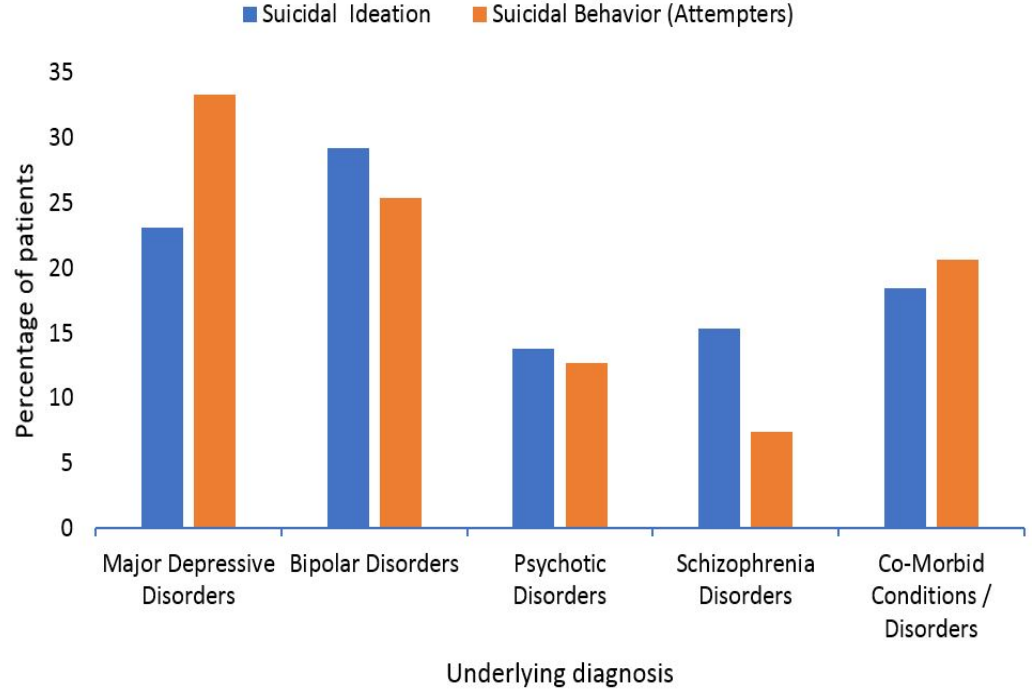
Figure 3. Variety and percentage wise distribution of the underlying diagnosis of the patients with suicidal behavior (Ideation and/or Attempts).